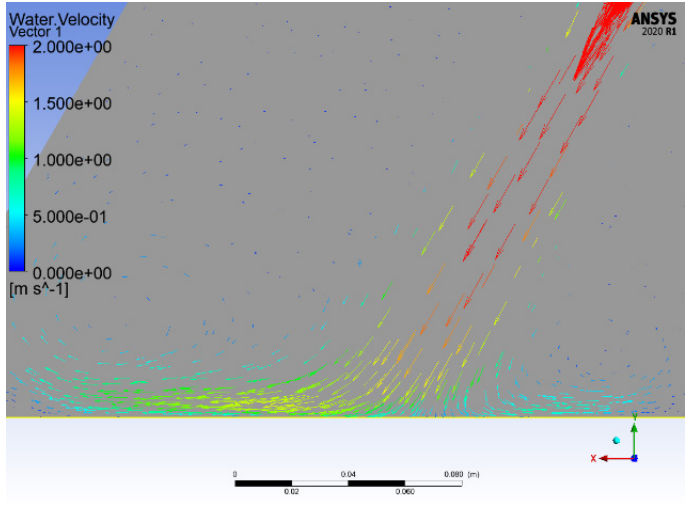
Figure 4. Velocity distribution of the fog field at 20 mm from the workpiece.